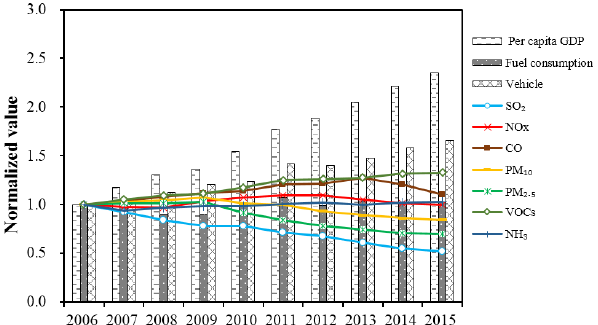
Figure 1. Trends in the air pollutant emissions, per capita GPD, fuel consumption, and vehicle population in Guangdong Province from 2006 to 2015 (all data are normalized to the year